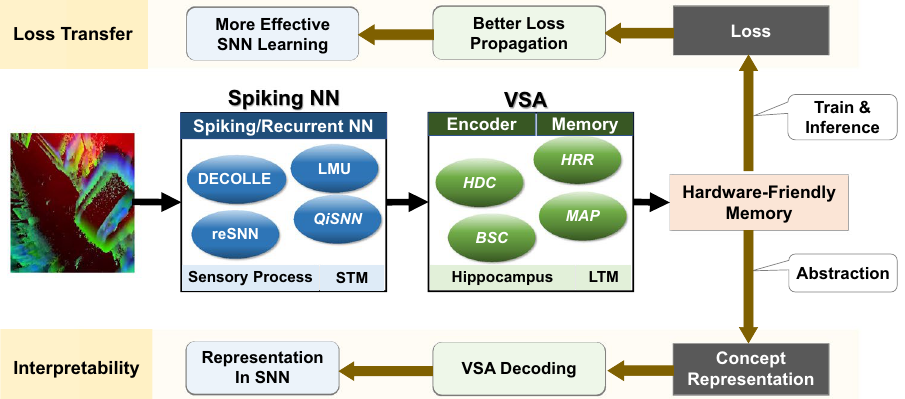
Figure 7. Overview of SpikeHD extended. Framework SpikeHD incorporates spiking neural networks and vector symbolic architecture at a high level. While our work has demonstrated one efficiency-oriented instance of the model with DECOLLE and HDC, other combinations may give rise to models of different strengths. Loss transfer one direction for future work is the back-propagation of loss from VSA. Better loss propagation to the SNN layer leads to more effective SNN training. Interpretability The decoding of HDC Memory and the interpretability of SNN lead to knowledge at the sensory data